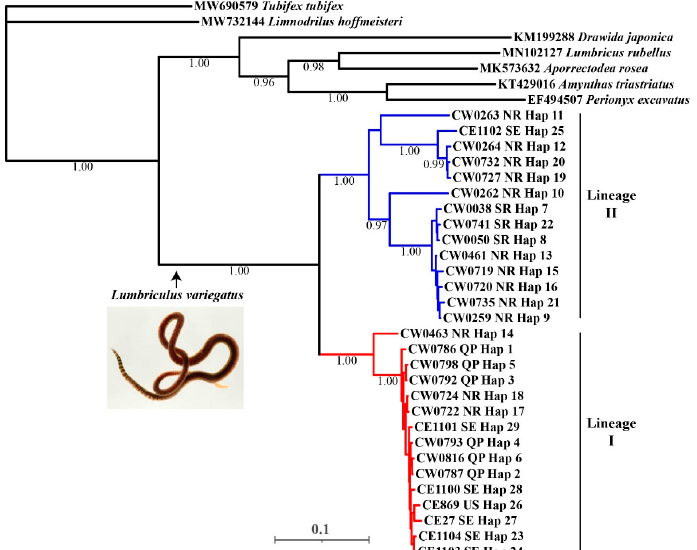
Figure 2. Bayesian inferences (BI) tree of Lumbriculus variegatus lineages based on the concatenated sequences of gene COI and 16S. Seven worms of Naididae, Lumbricidae, Moniligastridae, and Meg- ascolecidae were designated as the outgroup. The numbers below the branch point to the Bayesian posterior probability. BI posterior probabilities > 0.95 is indicated; QP, SR, NR, SE and US portions in the circle represent the Tibetan region, Southern China, Northeast China, Sweden and North America. Hap denotes Haplotype.